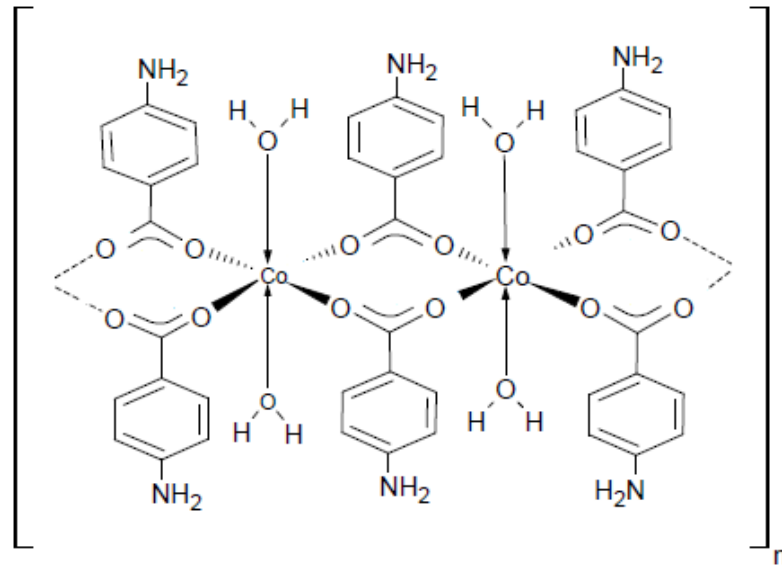
FIGURE 4 – Structural representation of catena -poly-{[trans(diaqua- kO )cobalt(II)]-bis( m - p -aminobenzoato- k²O,O’